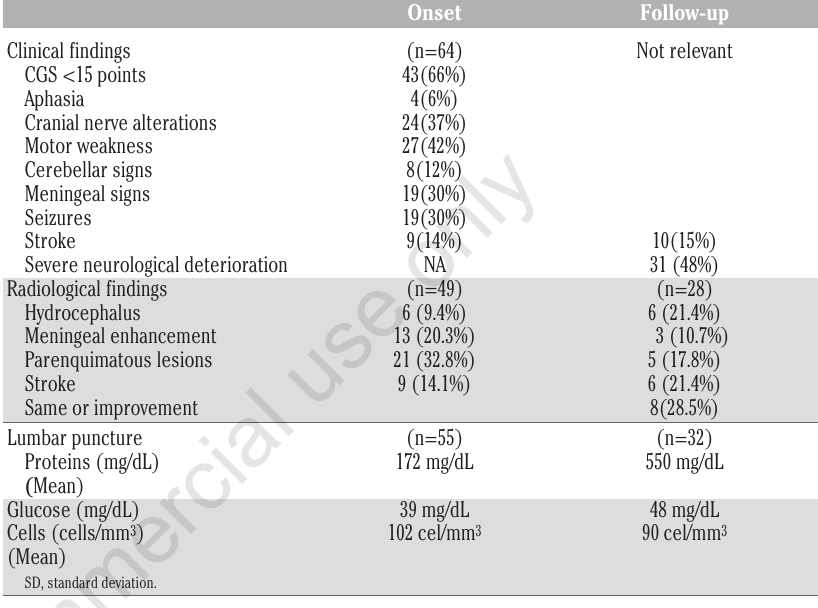
Table 1. Main characteristics at onset and follow-up between patients.